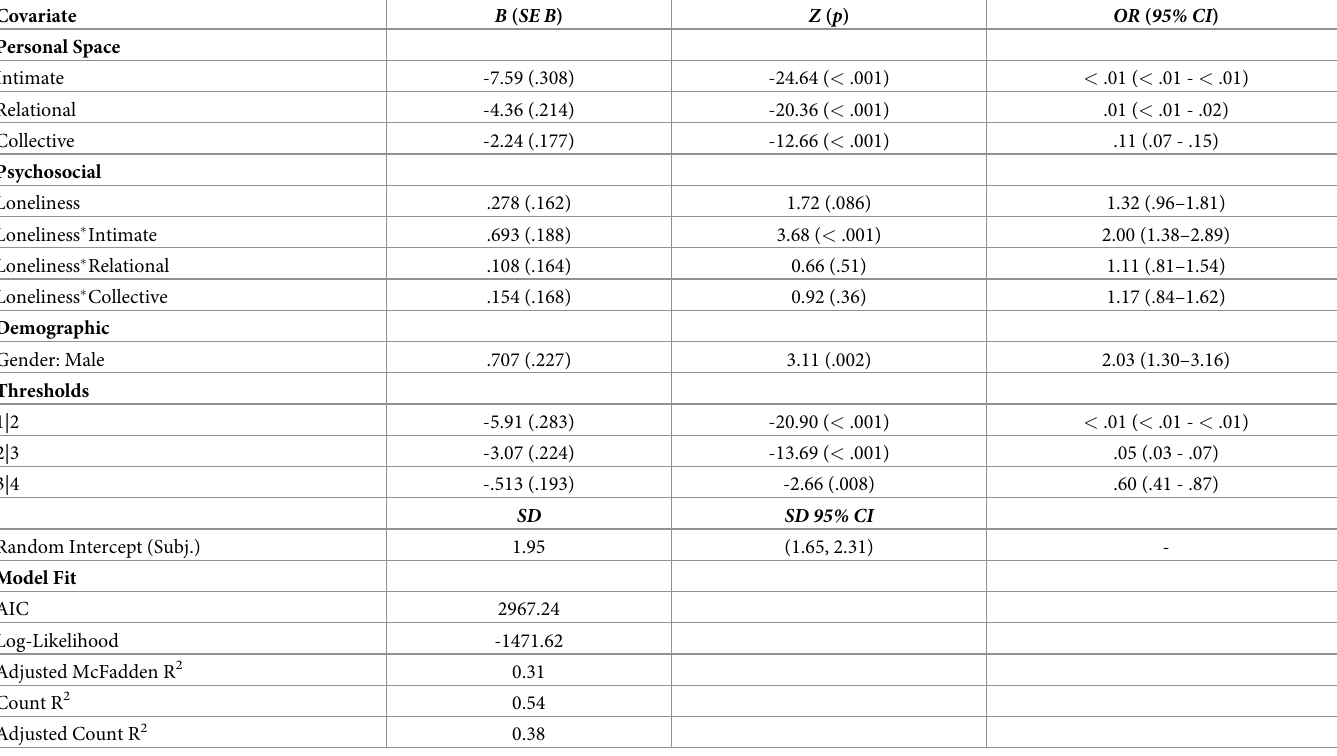
Table 2. Study 2 replication of Study 1 final